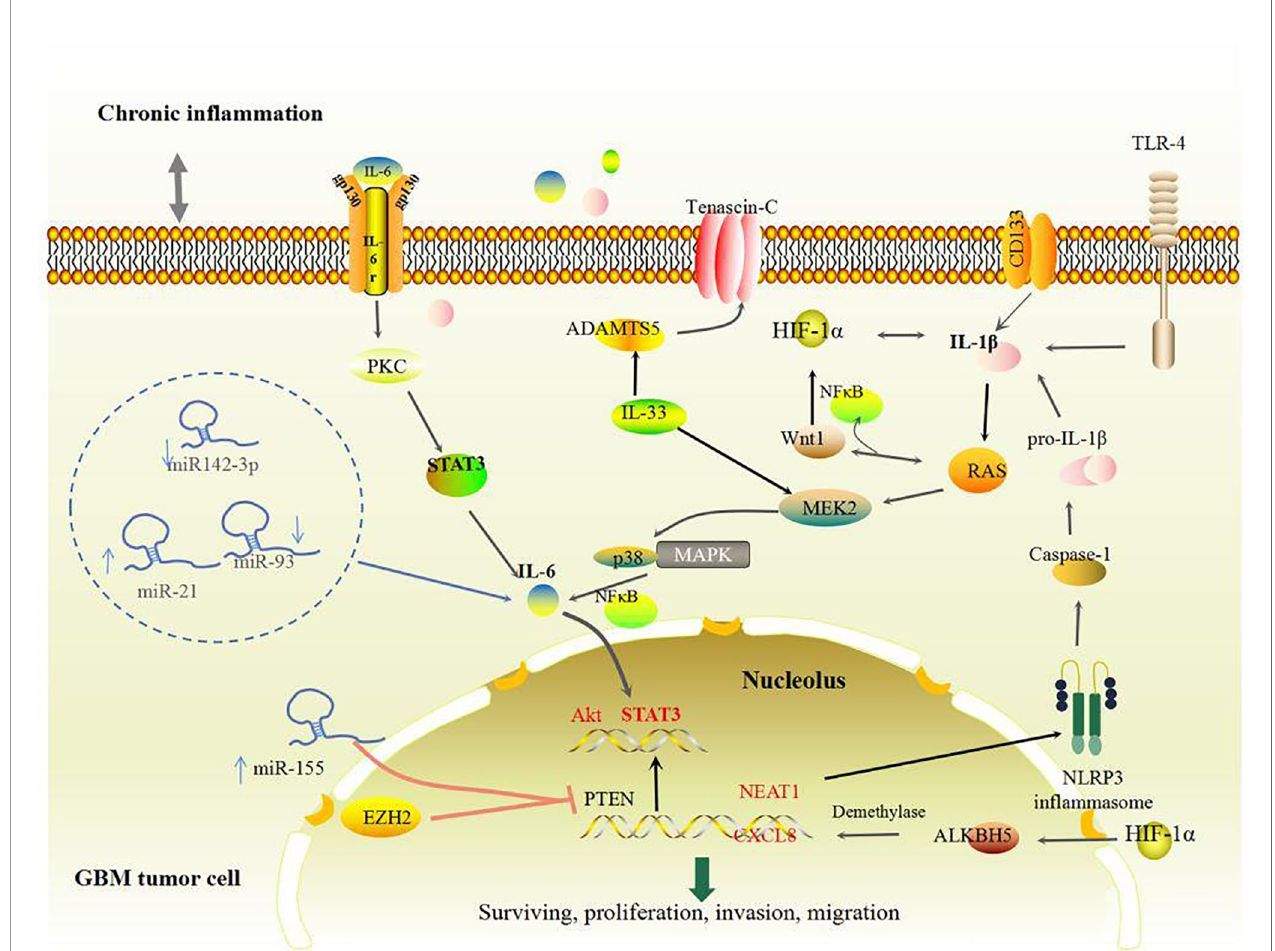
FIGURE 1 | In fl ammation-related changes in GBM tumor cells. GBM tumor cells produce abundant IL-1 and IL-6 through activating various pathways including STAT3, RAS, NF k B, NLRP3, and HIF-1 a pathways, thus creating a chronic in fl ammatory environment, which bene fi ts GBM